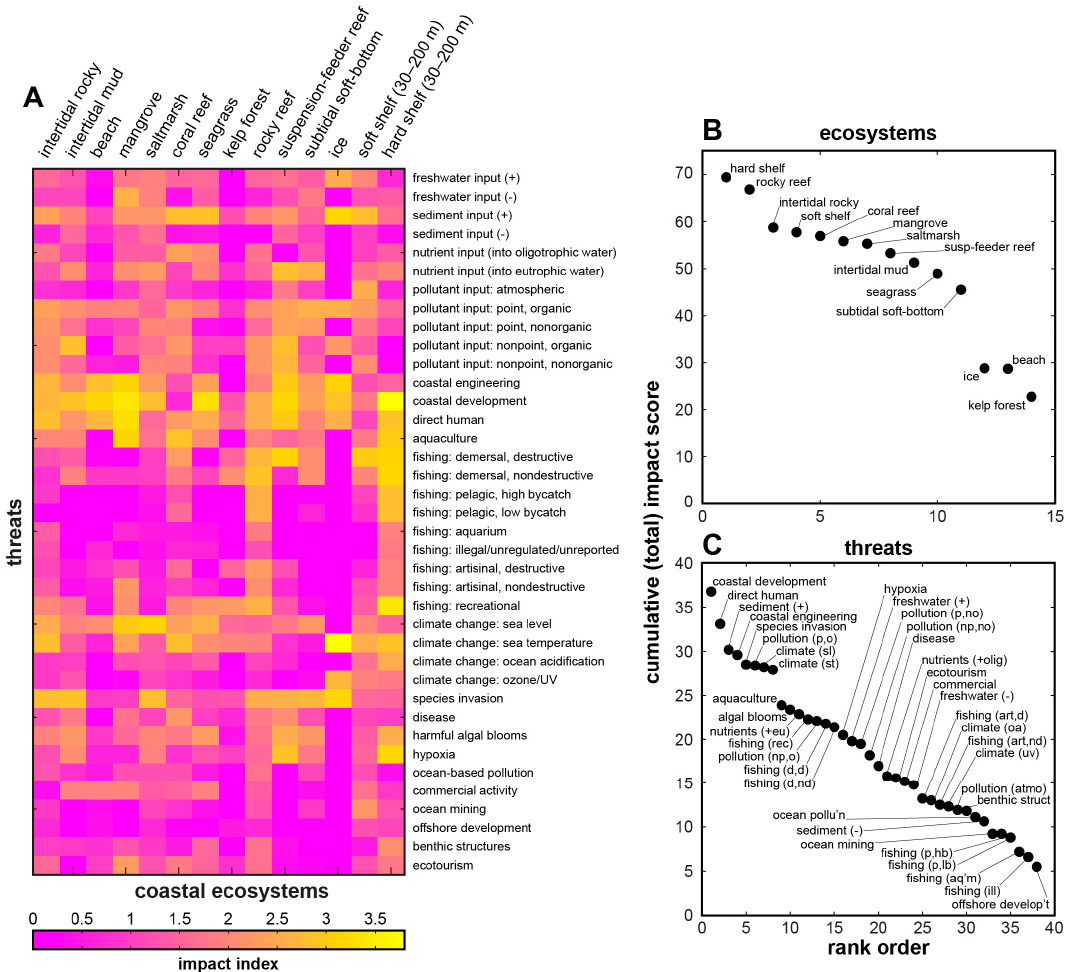
Figure 2. Coastal ecosystems and threats adapted from Halpern et al. [23]: ( A ) table of impact scores per ecosystem, shown by relative intensity; ( B ) ecosystems ranked by cumulative (total) impact score across threats; and ( C ) threats ranked by total impact score across coastal ecosystems.